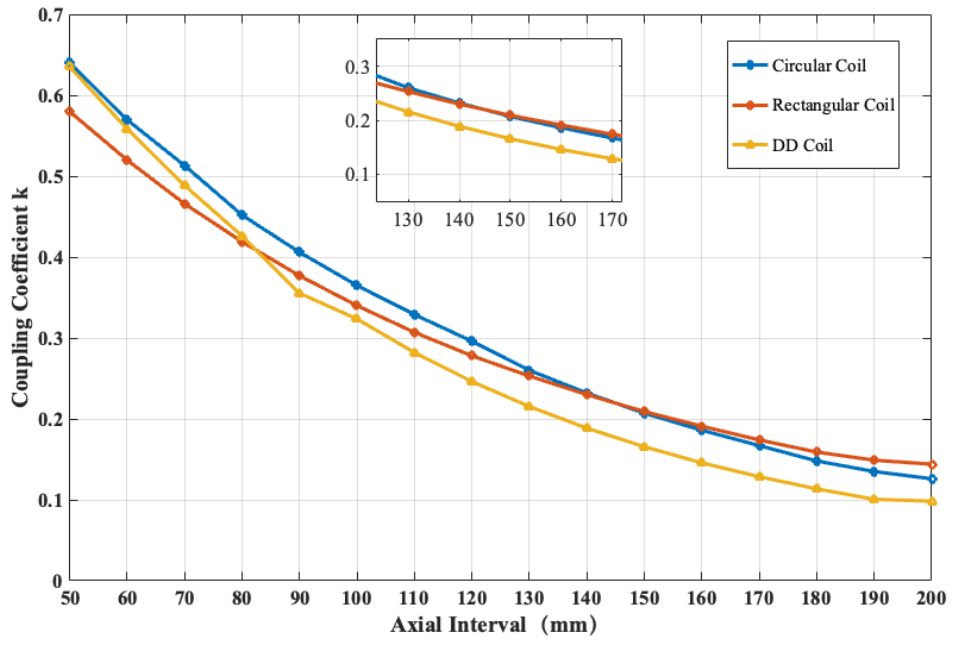
Figure 5. Magnetic coupling variation of coils under different axial